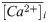
Mitochondrial depolarization promotes Ca2+ alternans.A. Time traces of membrane potential V, whole-cell averaged cytosolic Ca2+ concentration [Ca2+]¯i, SR Ca2+concentration [Ca2+]¯JSR, SERCA uptake flux, SR Ca2+ release flux via RyRs, mitochondrial free Ca2+
[Ca2+]¯m, open probability of mPTP P¯mPTP, mitochondrial membrane potential −Δψ¯, cytosolic ROS concentration [ROS]¯cyt, cytosolic CaMKII activation [CaMKII]¯act, cytosolic ATP concentration [ATP]¯cyt for normal control (αmPTP = 1) in black and mitochondrial depolarization (αmPTP = 60) conditions in red, respectively. PCL is 500 ms. Note that the horizontal bar above each variable means that the quantity is an averaged value over all the CRUs or mitochondria within the myocyte. B. Bifurcation diagrams of peak values of [Ca2+]¯i in the last two consecutive beats vs. PCL for control (black) and mitochondrial-depolarization (red) cases.